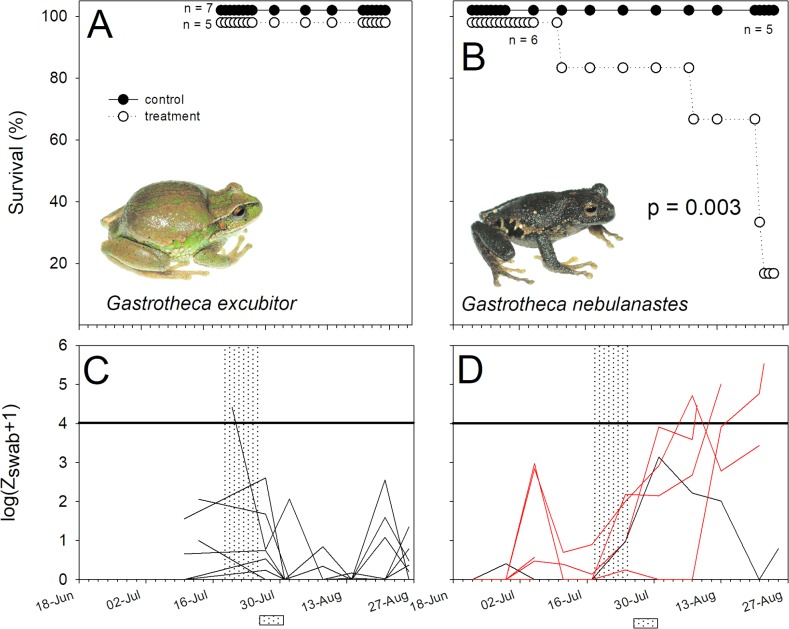
Differences in survival and Bd infection intensity in two species of marsupial frogs Gastrotheca (Hemiphractidae).(A, B) Percentage survival, and (C, D) variation in log-transformed zoospore equivalents (Bd infection intensity) of Bd-exposed individuals of Gastrotheca excubitor (left panels) and G. nebulanastes (right panel). The shaded band represents the period of daily immersion in itraconazole solution to clear infection, while the shaded box represents the period of experimental exposure to Bd. Red lines represent individuals that died during the trial.